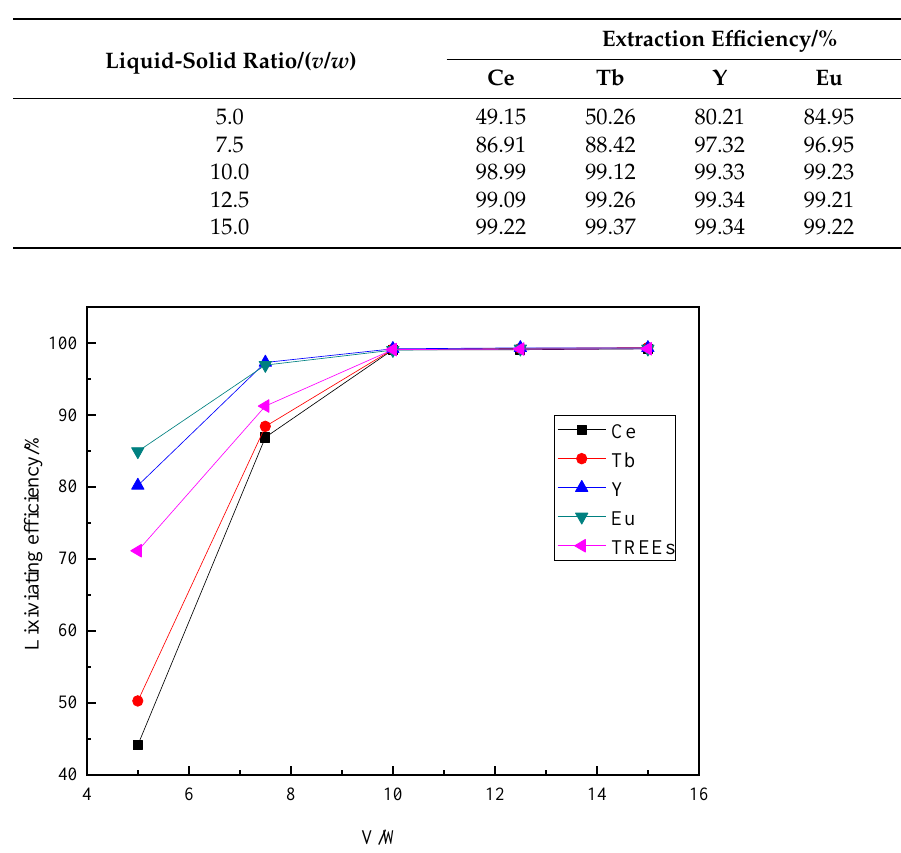
Figure 13. Influence of the liquid–solid ratio on the REEs leaching efficiencies (oxygen concentration in the mixed gas of 0.4%, roasting temperature of 700 °C, roasting time of 2.5 h, material ratio of phosphor powder to alkali 1:3, HCl solution concentration of 4 mol·L −1 , acid leaching temperature of 60 °C, and acid leaching time of 1 h).